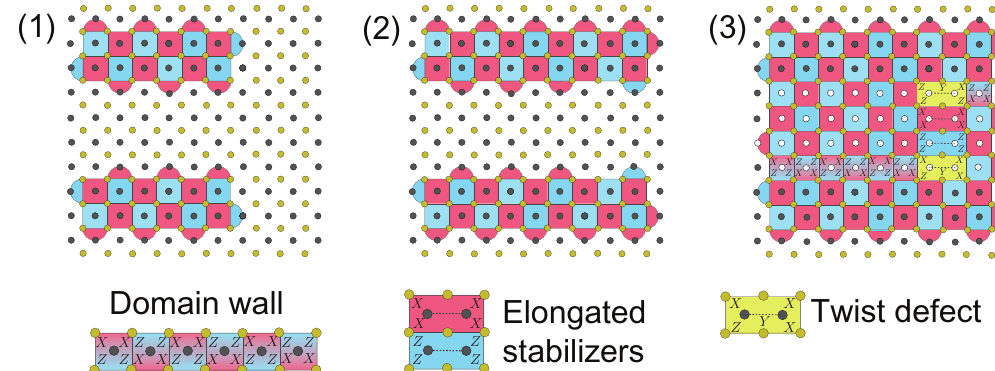
FIG. 3. A simple example of a lattice-surgery protocol using a twist defect in the bulk of the lattice to measure a Y ⊗ Y logical operator. Step (1) is the initial setup of two surface-code patches. In step (2), the surface-code patches are extended and corners moved using the routing space. Such an extension allows logical Y operators of the surface code to be expressed along a horizontal boundary. In step (3), we measure Y ⊗ Y using a combination of domain walls, elongated stabilizers, and two twist defects. The domain walls measure Z ⊗ Z ⊗ X ⊗ X stabilizers and typically offer no additional challenge compared to normal stabilizer measurements. The elongated stabilizers are long-range operators that pose an additional difficulty in hardware implementations. Elongated stabilizers can be implemented using either two ancilla qubits [e.g., prepared in a Greenberger-Horne-Zeilinger (GHZ) state], that we connect with a dashed line, or these two ancilla qubits necessarily merged into a single qubit (hardwired in the architecture) and using long-range gates. Twist defects (yellow plaquettes) present the biggest difficulty, since in addition to the challenges faced by elongated stabilizers, they also require a weight-5